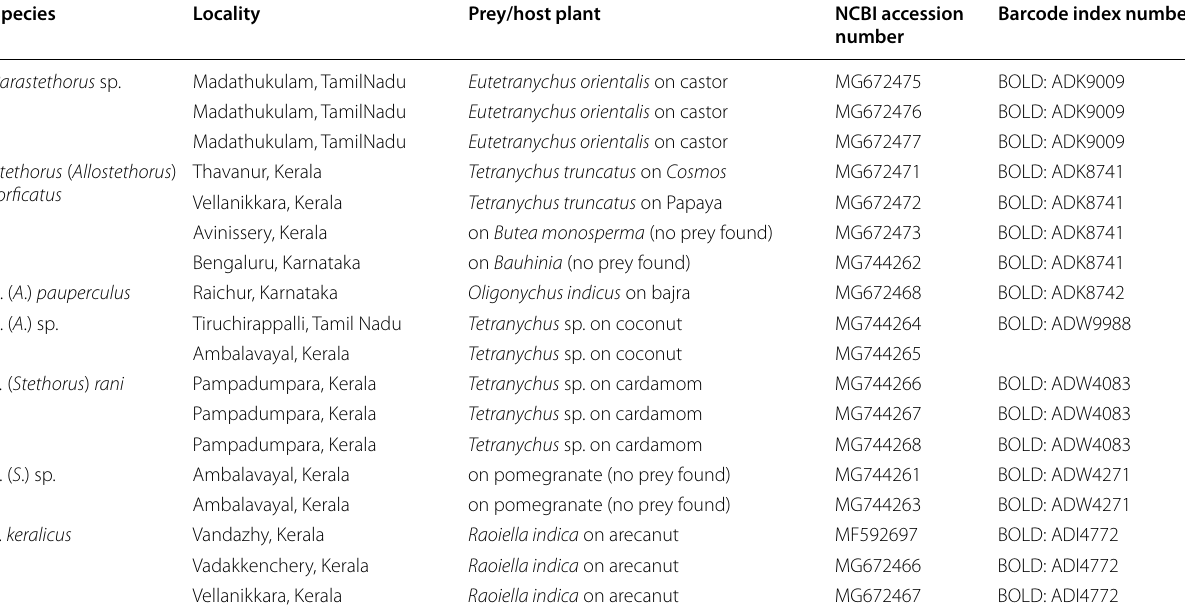
Table 4 NCBI accession number and Barcode index numbers for species of Stethorini Species